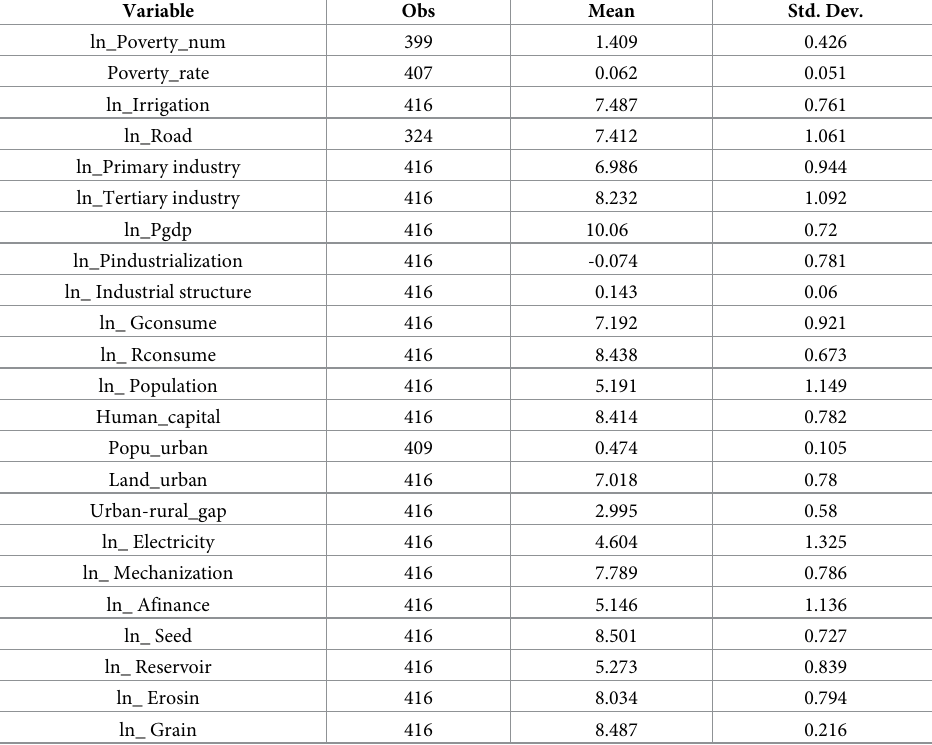
Table 2. Descriptive of the variables in the